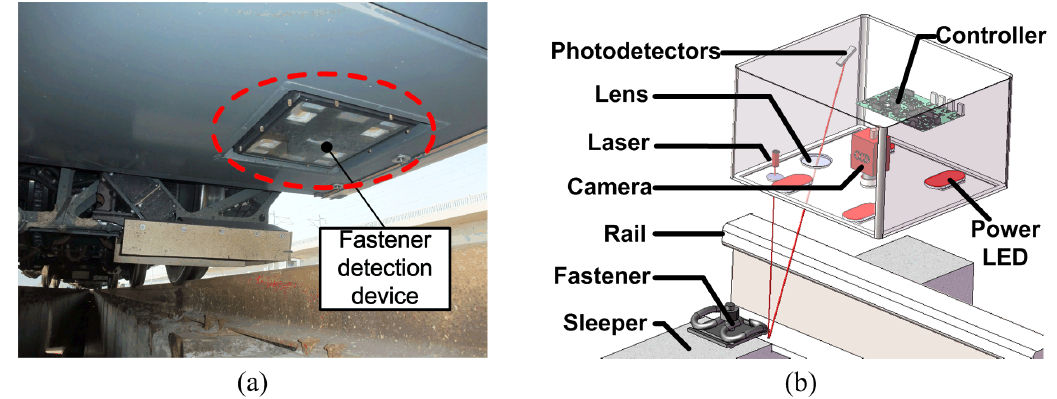
Figure 2. Detection system ( a ) and its composition ( b ).